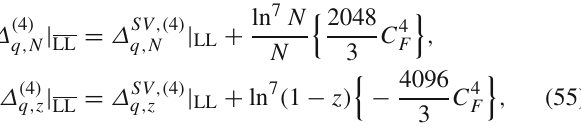
Table 2 The set of resummed exponents logarithmic accuracy. Here L j